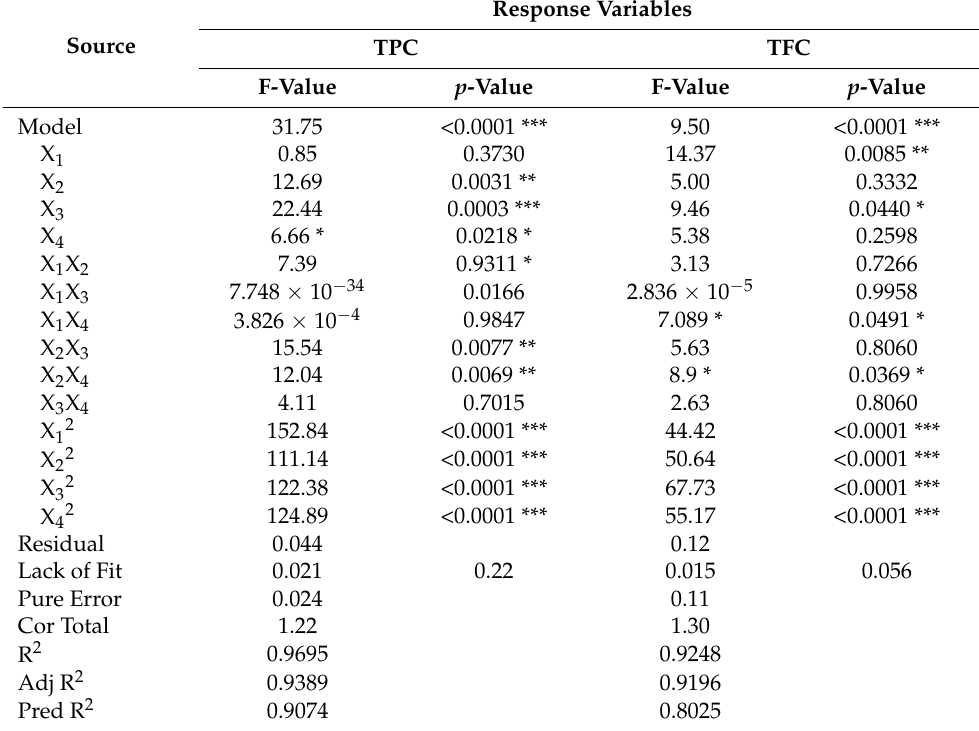
Table 3. Analysis of variance for regression model